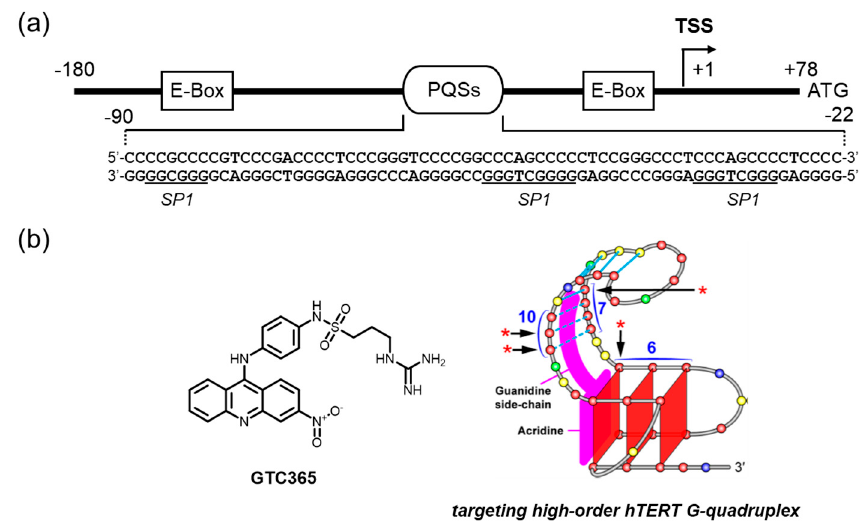
Figure 7. ( a ) The hTERT promoter has several PQSs, where two tandemly aligned G4s are suggested, and a molecule interacting with the specific motif of its G4 DNA and showing the downregulation of the hTERT gene transcription. The arrows with asterisks in the right illustration of the ( b ) represent bases that are protected in the presence of GTC365 from methylation by dimethyl sulfate (DMS) in the experiment performed in Reference 102. The protection suggests the occupied site of GTC365. The numbers represent the order of the runs of poly G observed in the hTERT promoter, which are numbered in Reference 102. The antitumor activity of GTC365 is summarized in Table 1. The right illustration of the Figure 7 ( b ) was adapted with permission from ref. 102.